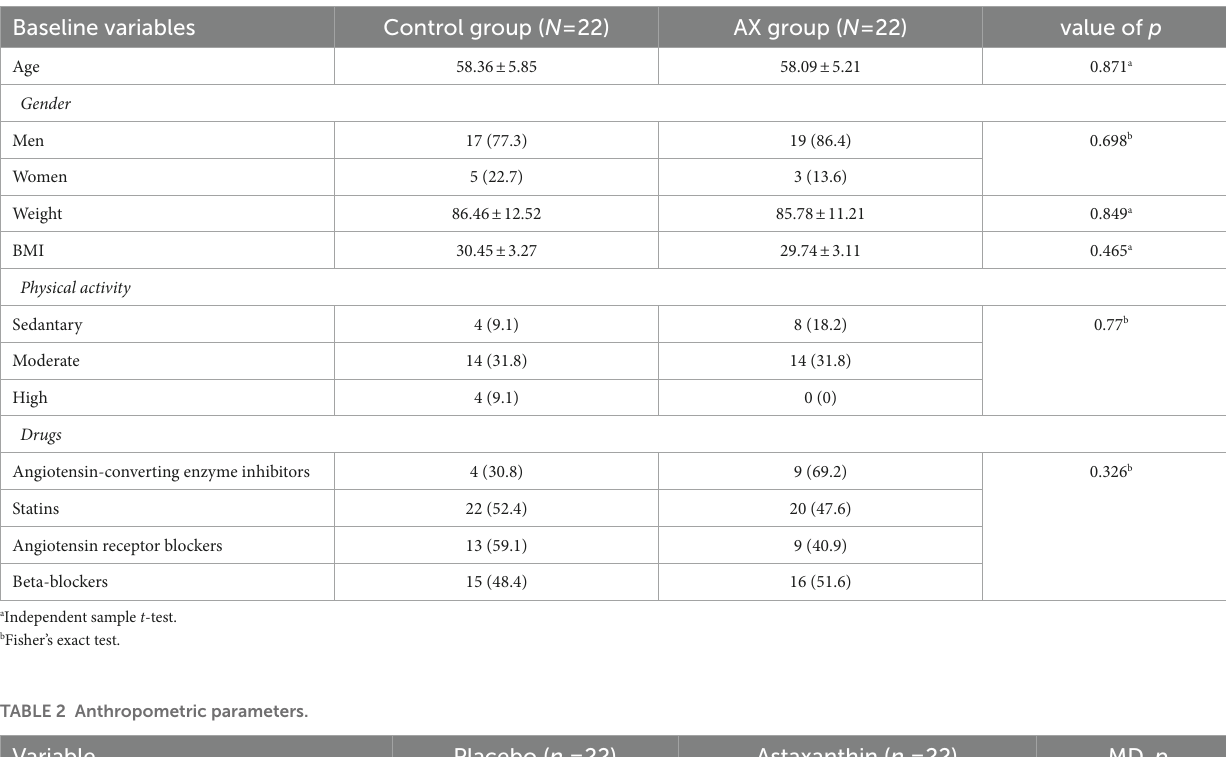
TABLE 1 Data are described as means ± SD or number (%).